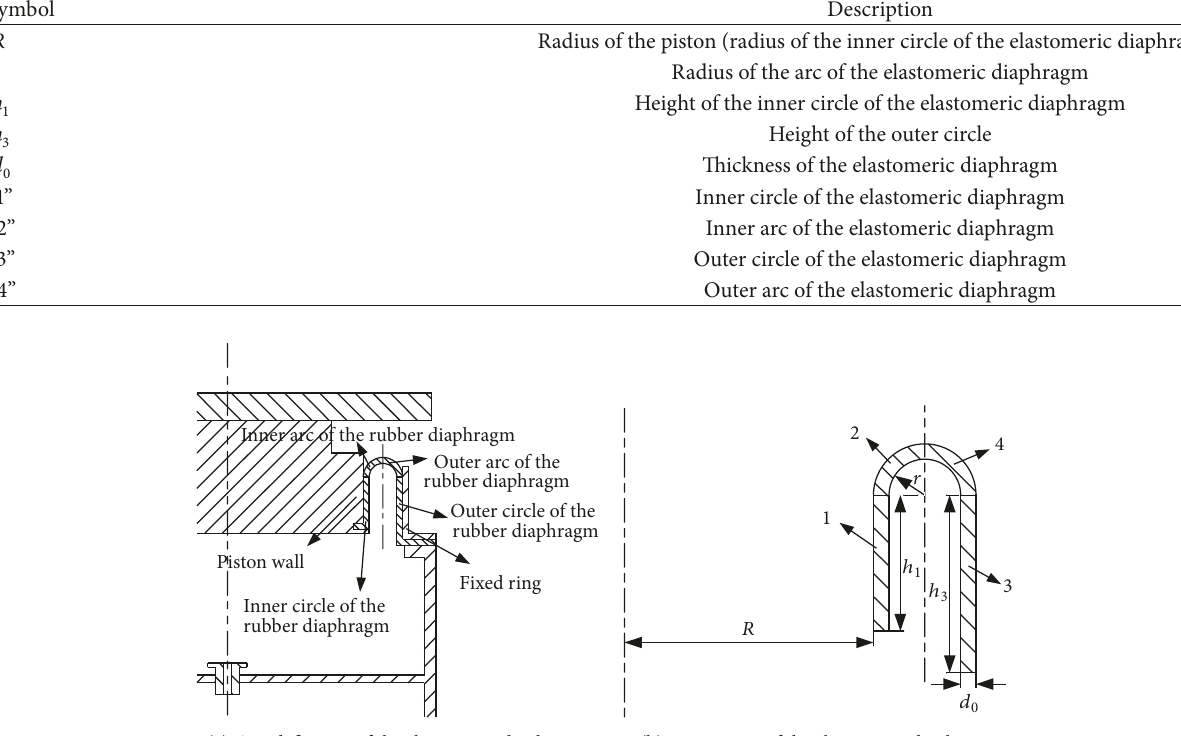
Table 1: Parameters of the elastomeric diaphragm.